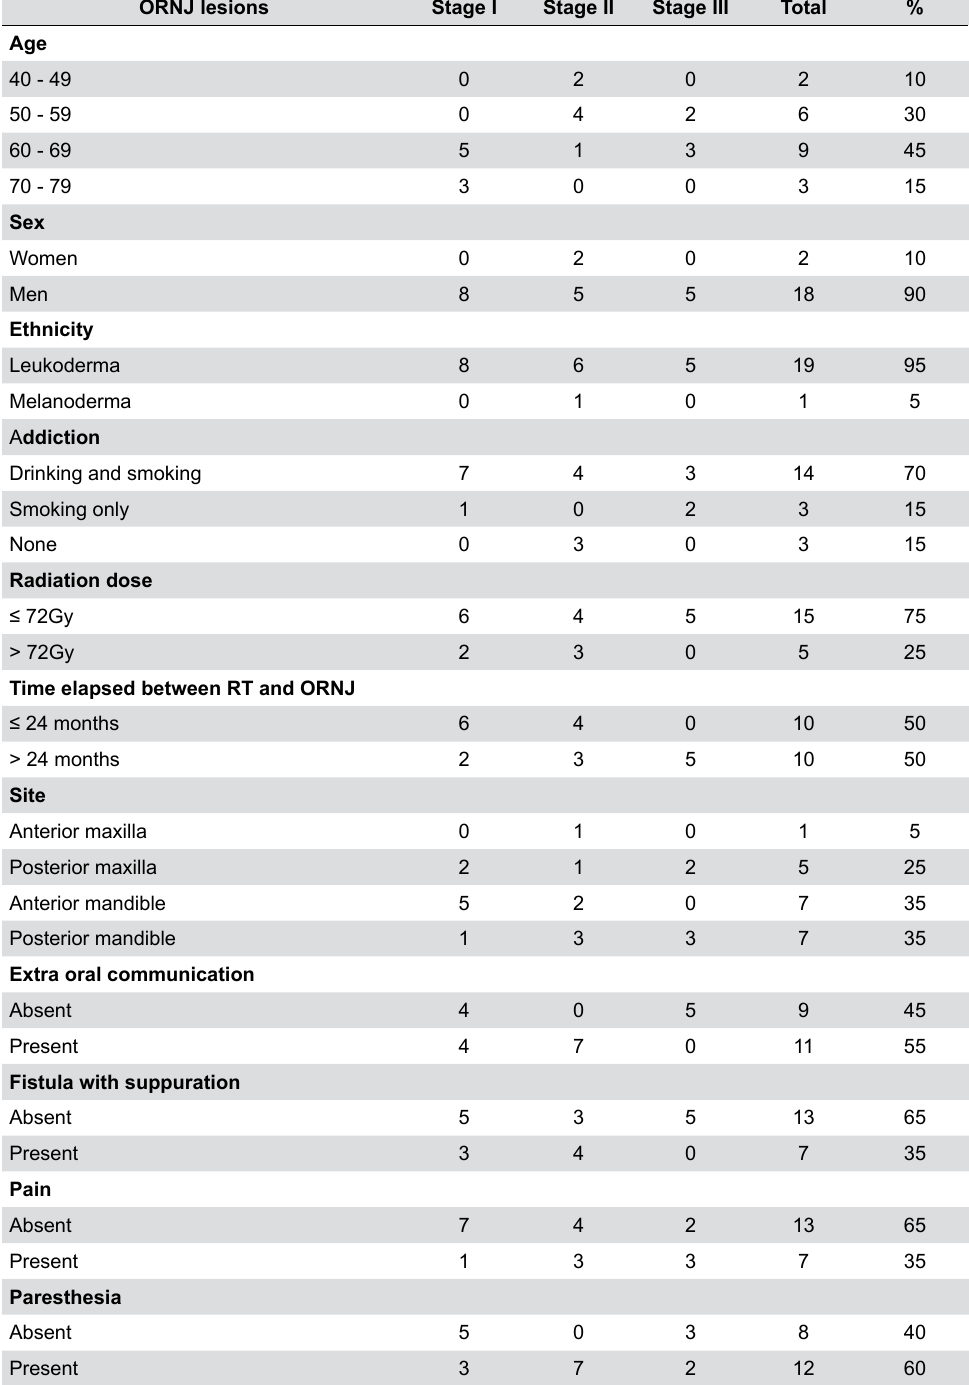
Table 2- Epidemiological and clinical features of the